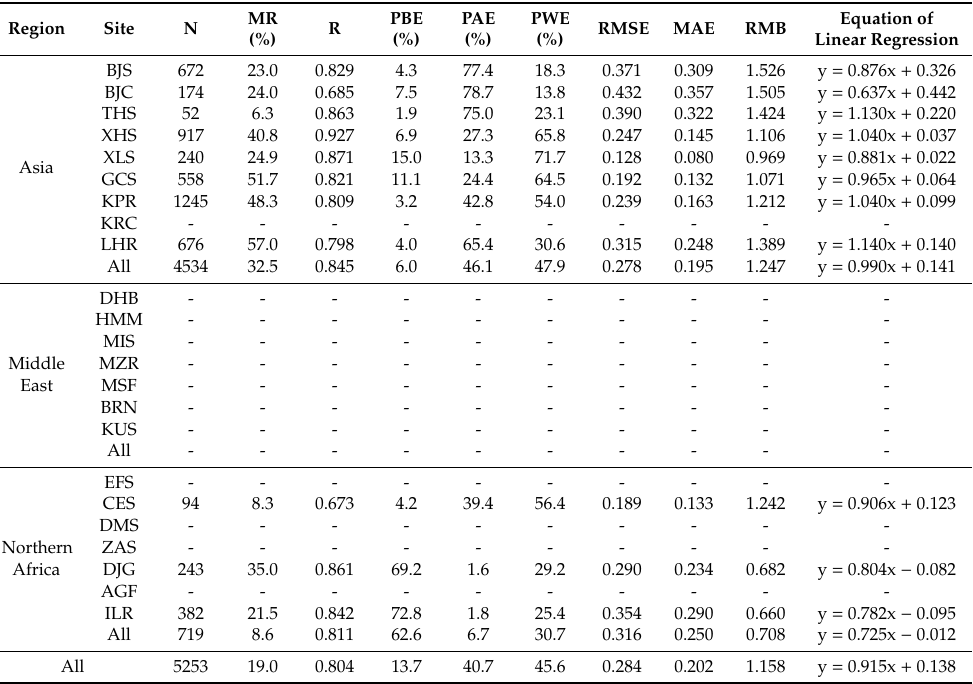
Table 2. Statistical summary for validation of MOD04 DT AOD